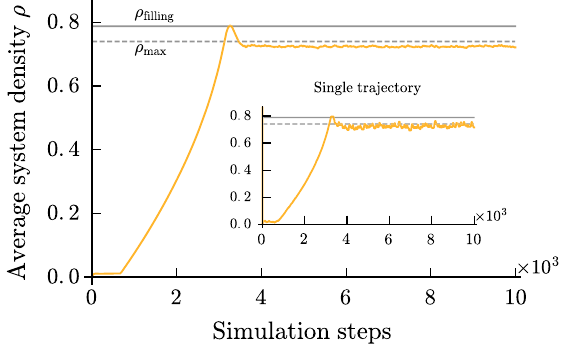
FIG. 12. Temporal evolution of the system density for α → 0 , β → 0 , β ≪ α . As the number of simulation steps increases ( x axis), particles enter the system, “ pile up ” at the end, and create ≈ 0 . 79 (solid line). As soon as an average density close to ρ filling particles leave the system, the presence of loose particles is suppressed, which leads to a drop of the average density until the ≈ 0 . 73 is reached. The dashed line maximal dynamic density ρ max depicts the result of the analytic approach for ρ described in max this section. Here, the density is obtained from an ensemble and spatial average. A single realization (inset) shows that the average system density (i.e., spatial average) oscillates around ρ , max which can be explained by large reordering events if stable particles are removed after several loose particles are extracted. Simulation parameters include α ¼ 0 . 02 , β ¼ 10 − 4 , δ ¼ 1 = 2 , W ¼ 2 , L ¼ 4096